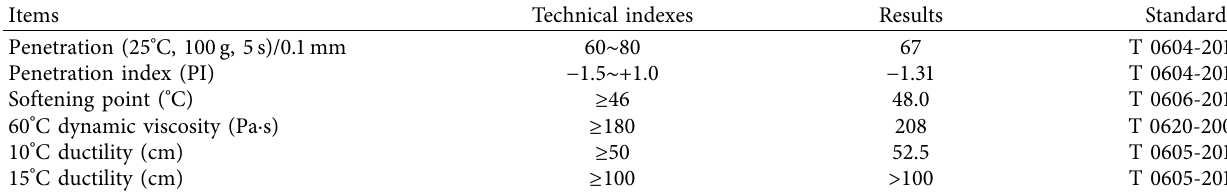
Table 1: Base asphalt technical performance index.